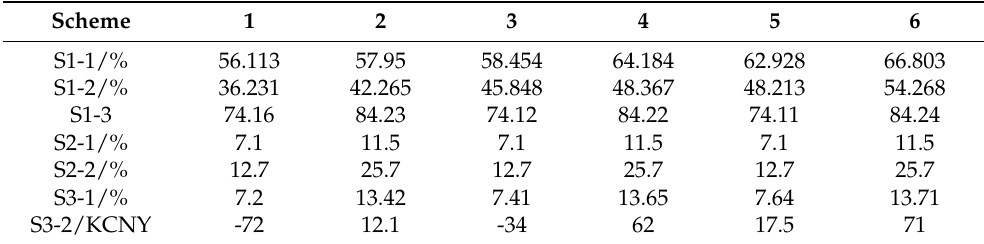
Figure 7. Power operation diagram under Scheme C. According to the calculation method of each indicator in the low-carbon capability evaluation system (Formulas (1)–(15)), the indicators of the low-carbon situation and mar- ket structure are calculated, respectively, and the calculation results are shown in Tables 3 and 4. Table 3. Calculation results of low-carbon situation indicators under each scheme.